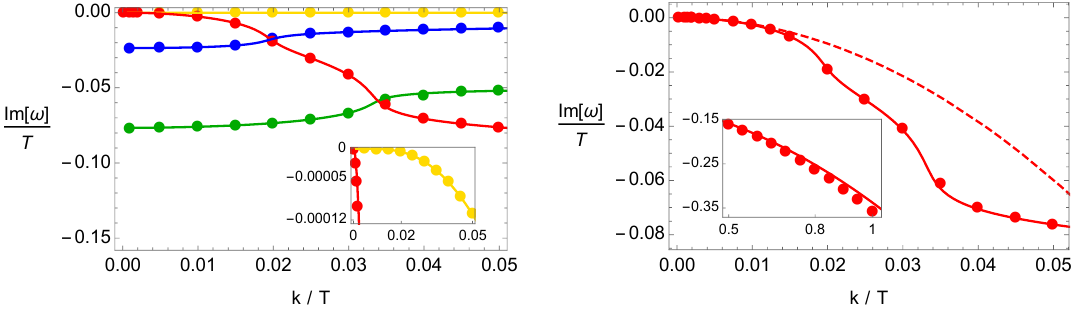
Figure 22 . Dispersion relations of the lowest QNMs at finite density ( µ/T = 0 . 5) and B/T 2 = 0 . 5 corresponding to figure 3 in the main text. The solid lines are the hydrodynamic formulas without truncating the solution while the dashed line correspond to the controlled hydrodynamic predictions shown in the text. See section 2.5 for more